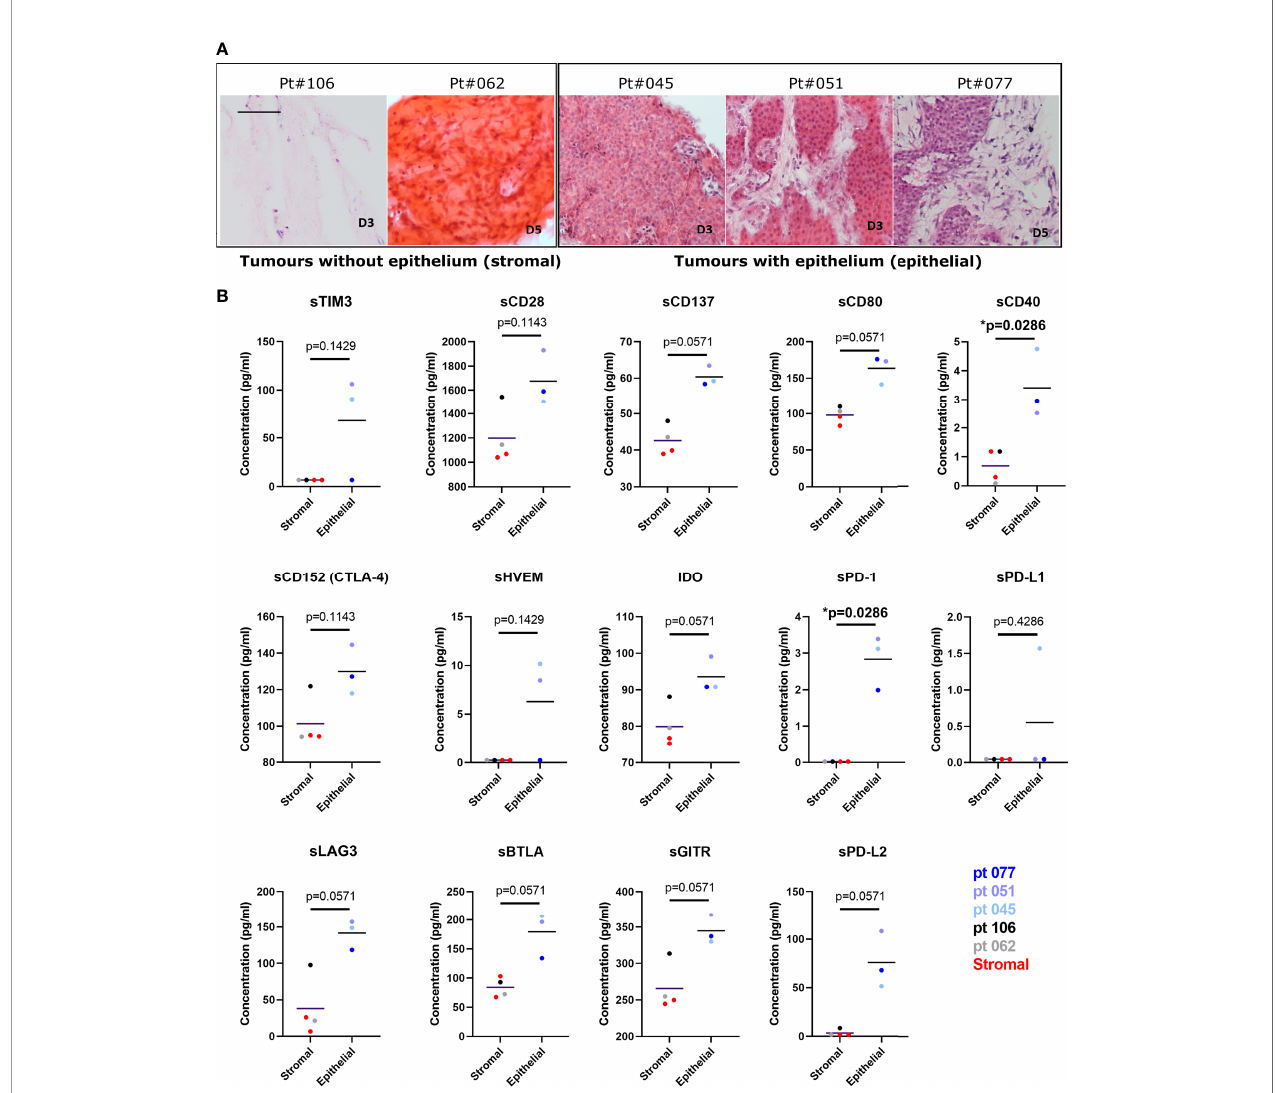
FIGURE 6 | The release of soluble checkpoint receptors (solCRs) by LM-NEN PCTS is dependent on the presence of tumour epithelium. (A) Histological assessment of the content of stroma and epithelium in LM-NEN PCTS at day 3 or 5 in culture (see Figure S3 for images related to HCC with prevalent stroma). (B) solCRs quanti fi ed in supernatants at day 3 in culture derived from LM-NEN slices with prevalent epithelium (n patients =3) and slices with prevalent stroma (n patients =4, 2 LM-NEN + 2 primary liver cancer). Each datapoint indicates the average of 3 technical replicates (slice supernatants) per patient. LM-NEN in blue and grey, stroma primary liver cancer in red. P values following the comparison of stroma slices vs epithelial LM-NEN slices are indicated in